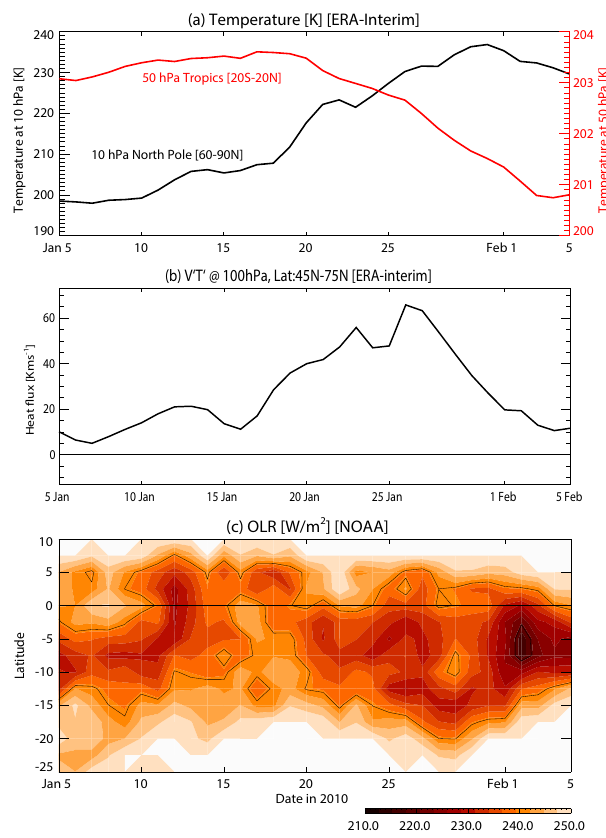
Figure 1. (a) Time series of observed zonal mean temperature (K) in the northern high latitude at 10hPa (black line) and tropical at 50hPa (red line) from 5 January to 5 February 2010. Note the dif- ferent temperature scales for the polar (left) and tropical (right) regions. (b) Time series of observed zonal mean eddy heat flux (Kms − 1 ) at 100hPa averaged between 45 ◦ N and 75 ◦ N. (c) Time– latitude (25 ◦ S–10 ◦ N) section of NOAA observed zonal mean OLR (Wm − 2 ). The horizontal line indicates the